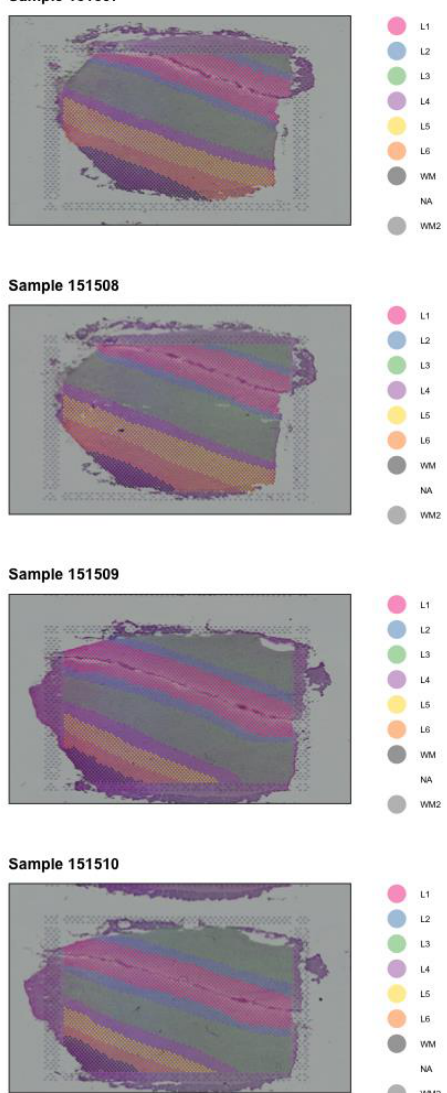
Figure 1. Layer plot of the four analyzed DLPC tissue samples.